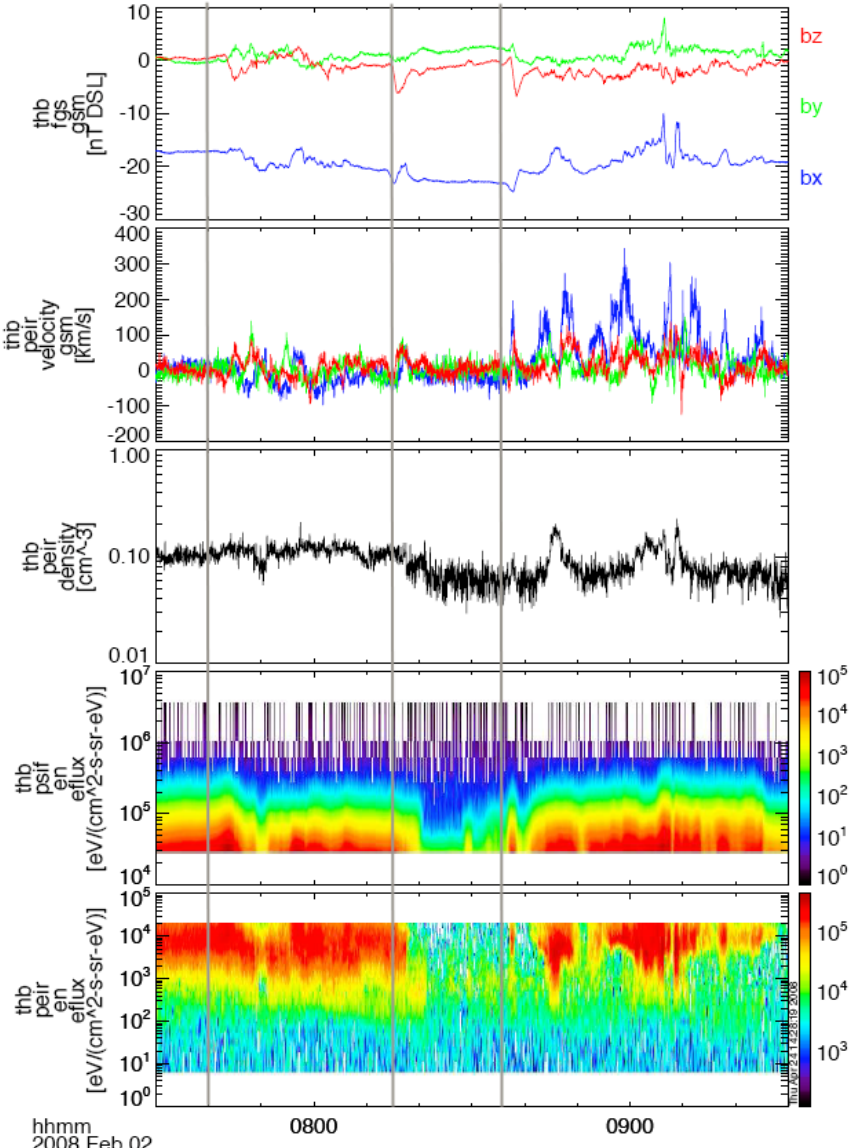
Figure 2. Observations with THEMIS B (x=-29.6, y=-1.38, z=-8.65) of magnetic field Fig. 2. Observations with THEMIS B ( x = − 29.6, y = − 1.38, z = − 8.65) of magnetic field (nT), plasma velocity (km/s), plasma density (cm − 3 ), (nT), plasma velocity (km/s), plasma density (cm -3 ), higher and lower energy ion higher and lower energy ion spectrogram on 2 February 2008 as a function of spectrogram on February 2, 2008 as a function of UT..